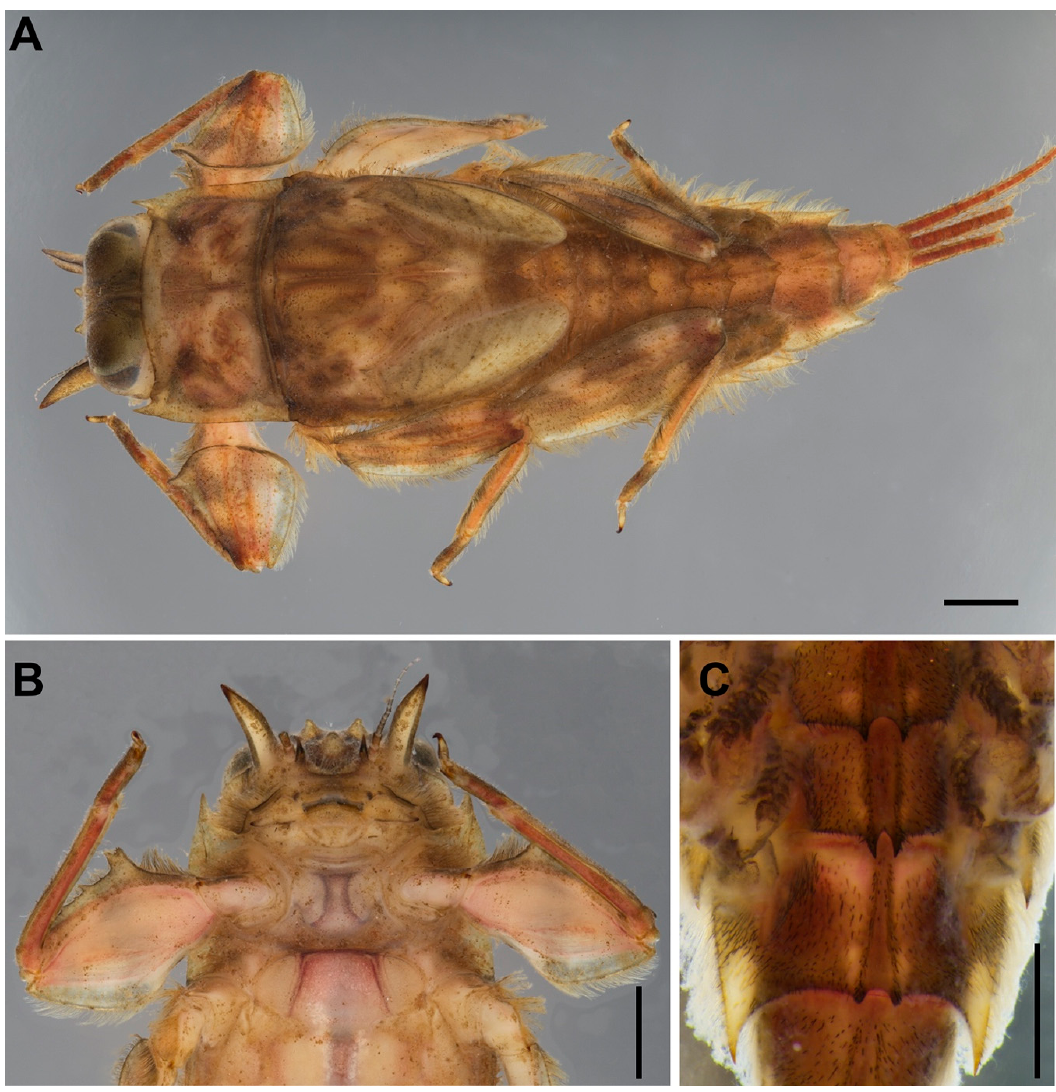
Figure 1. Vietnamella nanensis sp. n. (paratype) ( A ) habitus of larva; ( B ) ventral view of head and thorax; ( C ) abdominal terga VI–VII. Scale bars: 1 mm.